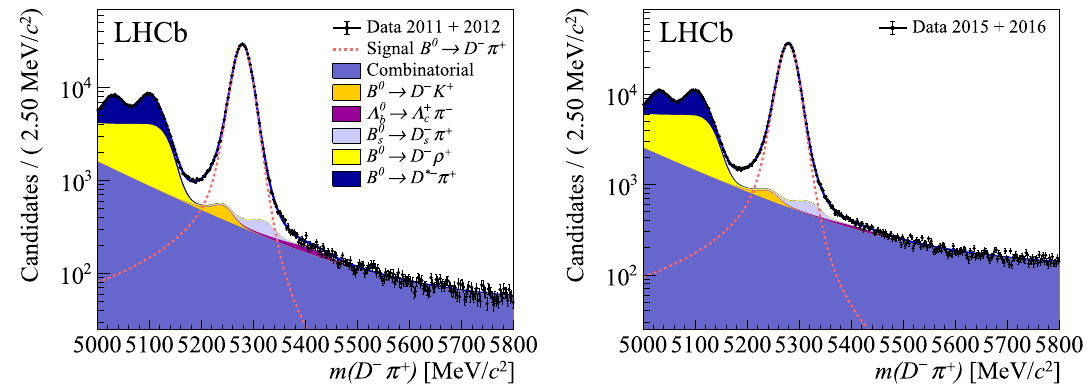
Fig. 2 The invariant mass distributions of normalisation B 0 → D − π + candidates, for (left) Run 1 and (right) Run 2 data samples. Overlaid are the fit projections along with the signal and background contributions 5 Signal